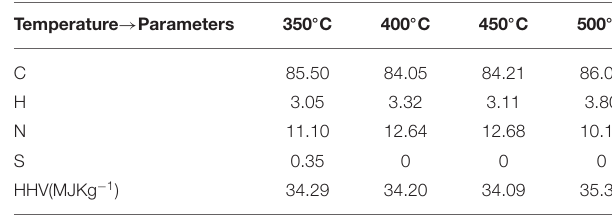
TABLE 6 | Ultimate and HHV analysis for pretreated ASR pyrolysis